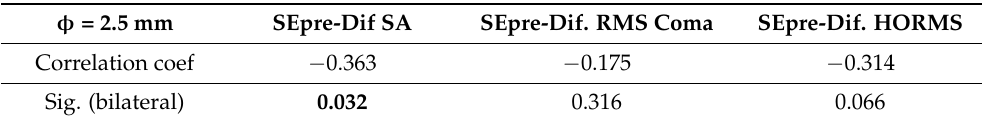
Table 7. Correlations for 2.5 mm pupil size of preoperative SE with the difference between pre- and post-surgery values obtained for SA, RMS coma and RMS HOAS. Statistically significant values are highlighted in